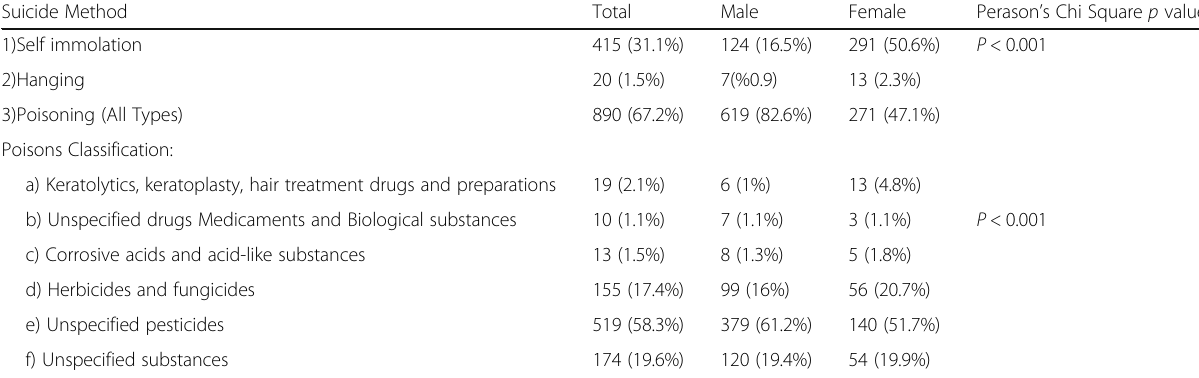
Table 3 Distribution of Suicide Method Suicide Method